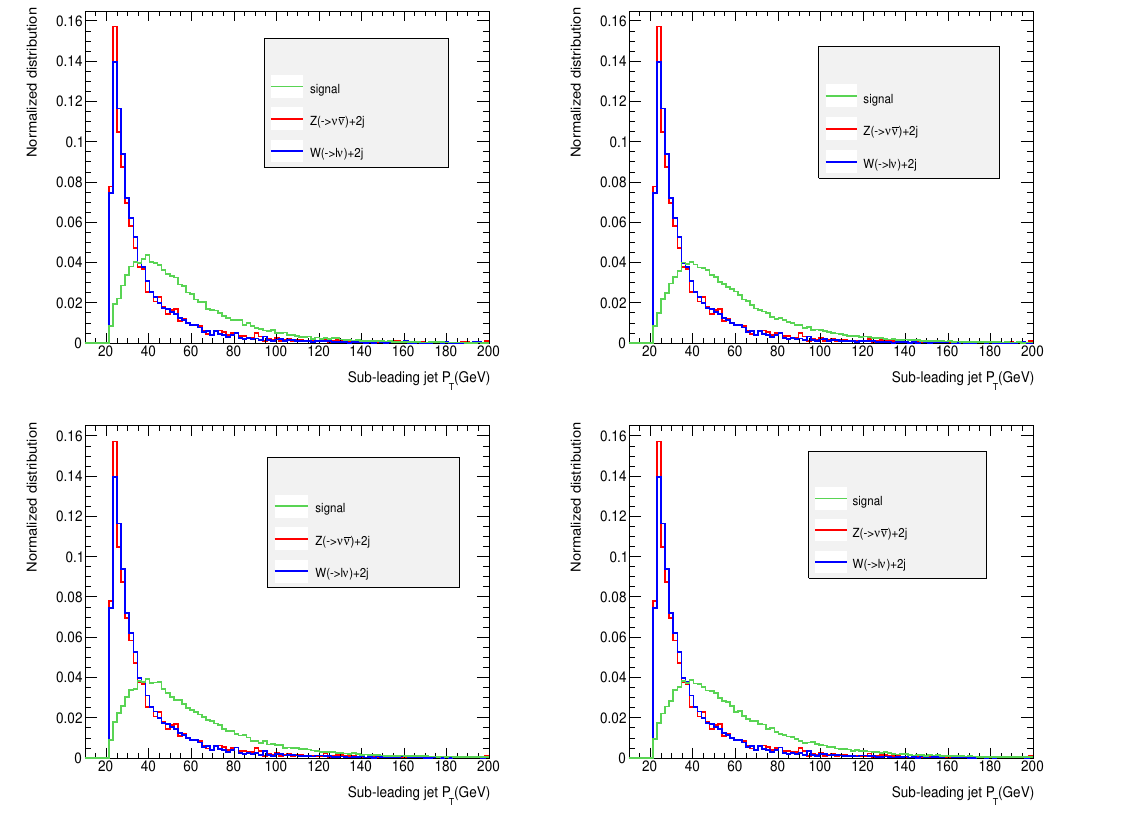
Figure 11 . P T distribution of the sub-leading jet for vector boson fusion signal and background processes, Type I BP I(top left), Type I BP II(top right), Type II BP I(bottom left) and Type II BP II(bottom right).